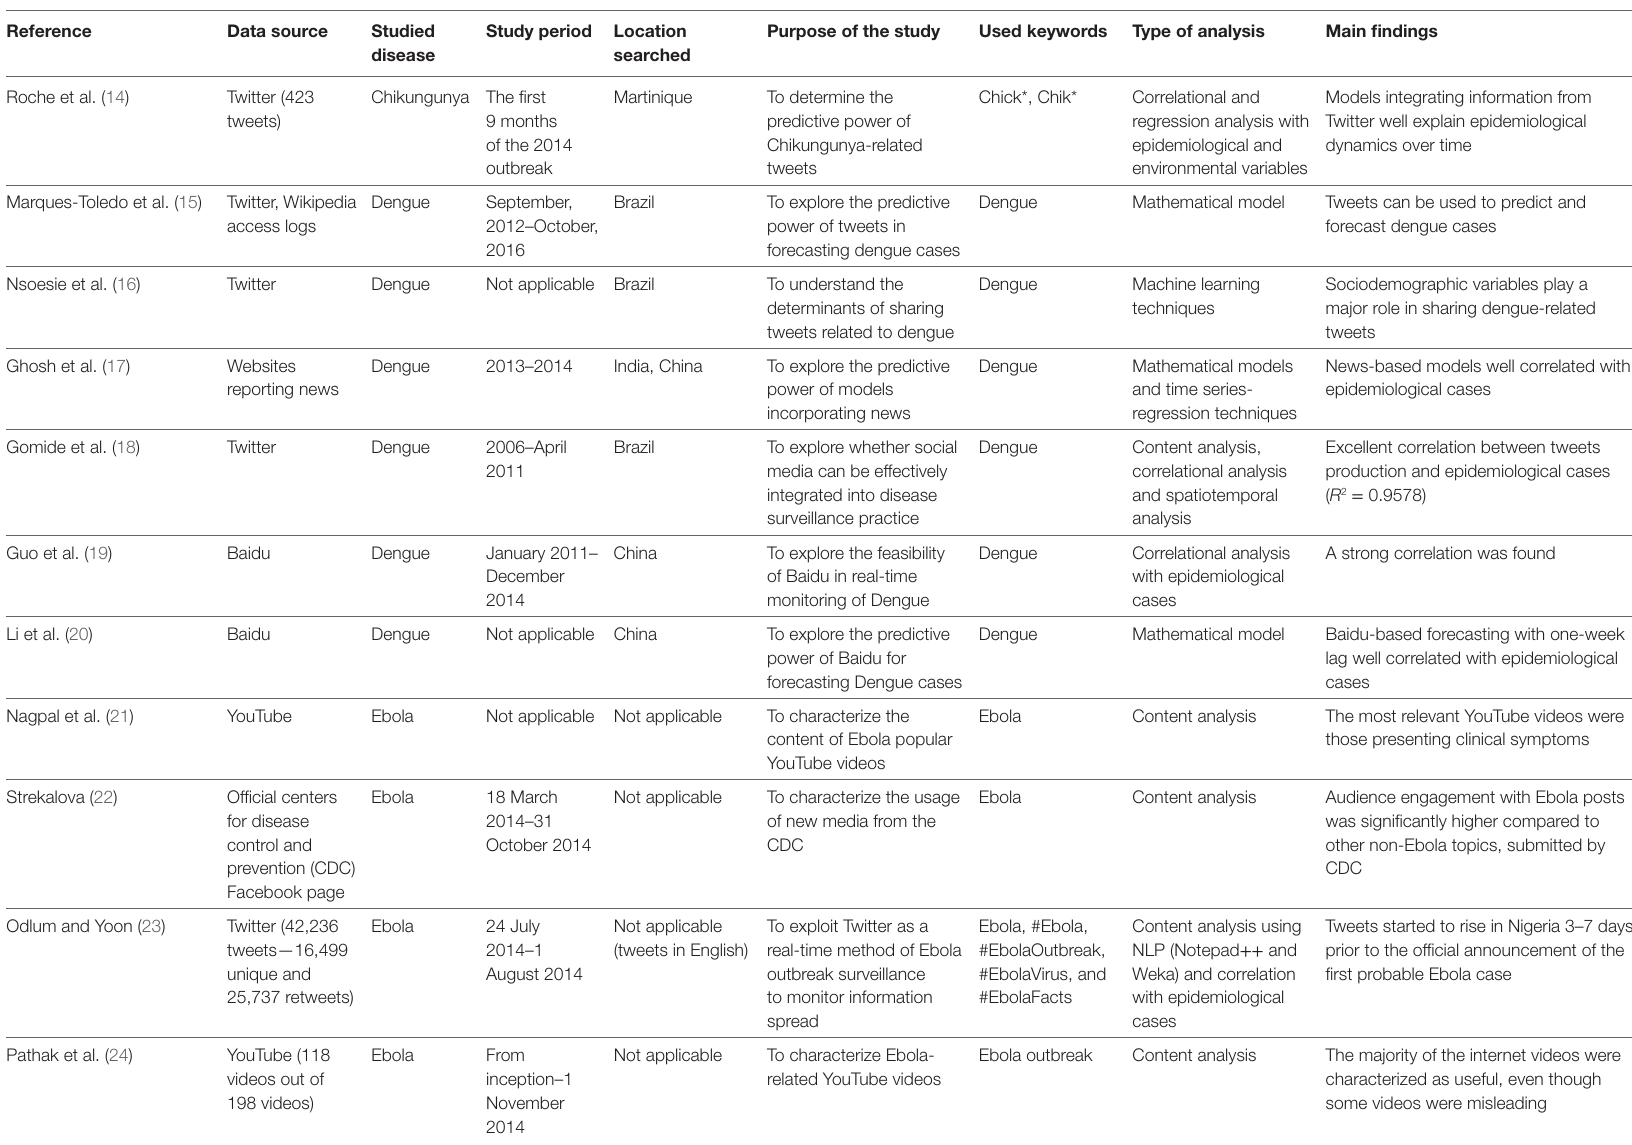
taBLe 2 | Characteristics of studies included in the current systematic